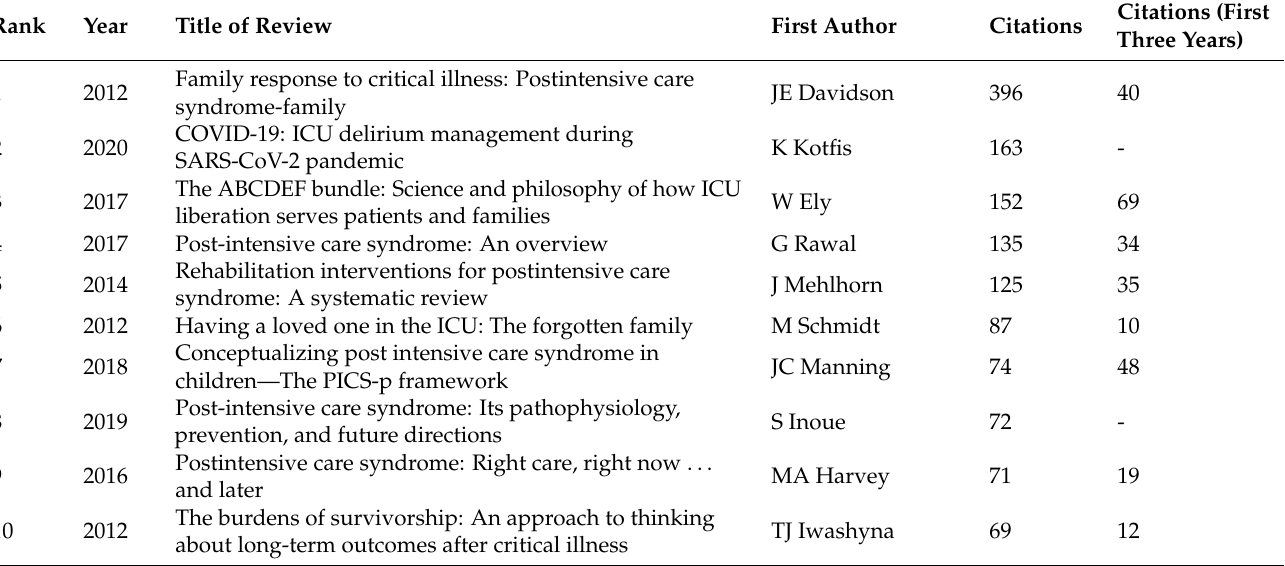
Table 6. Most-cited reviews on post-intensive care syndrome, ordered by